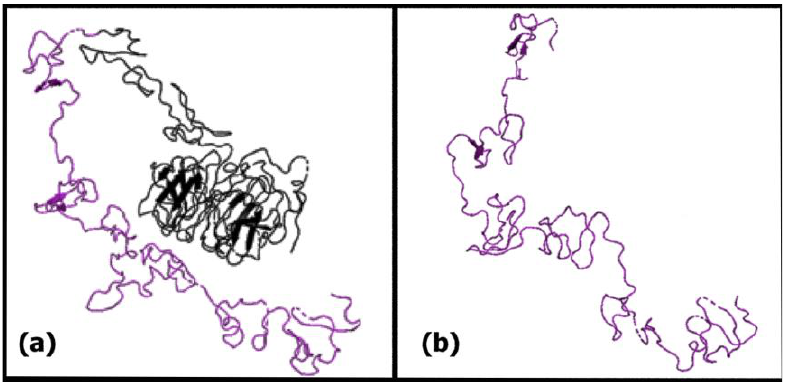
Figure 1. Phyre2 model generated for CR3–10 region of CCR2 subunit of LRP1 receptor ( a ) before cleavage of the beta-propeller region (black); ( b ) after cleavage of beta-propeller region.